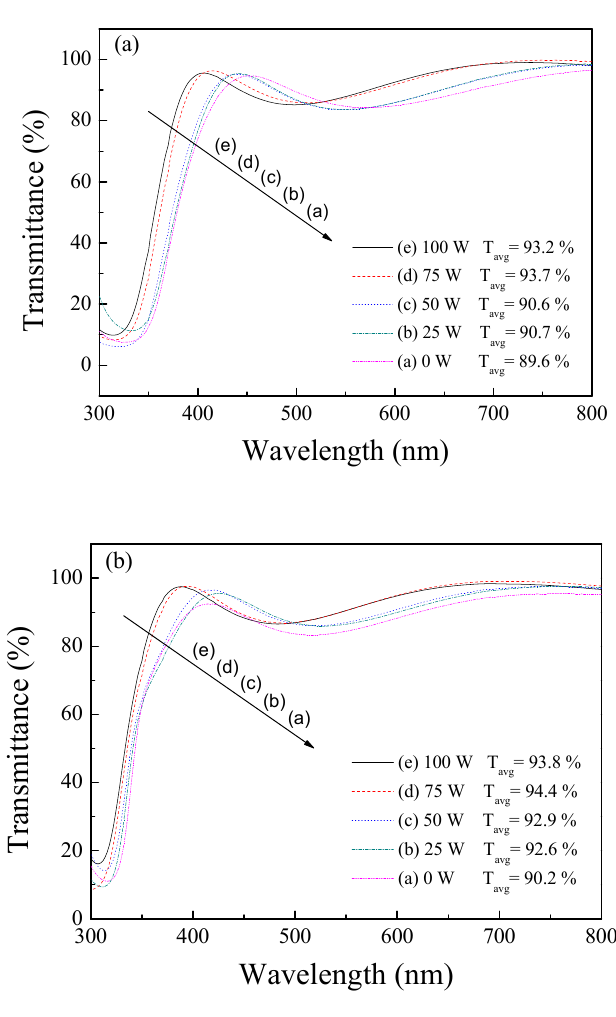
Figure 3. Optical transmission spectra for the studied film ( a ) as-deposited state and ( b ) post-annealed at 600 °C.